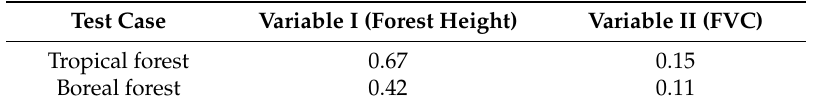
Table 1. Standard regression coe ffi cients for independent variables in the tropical and boreal forest